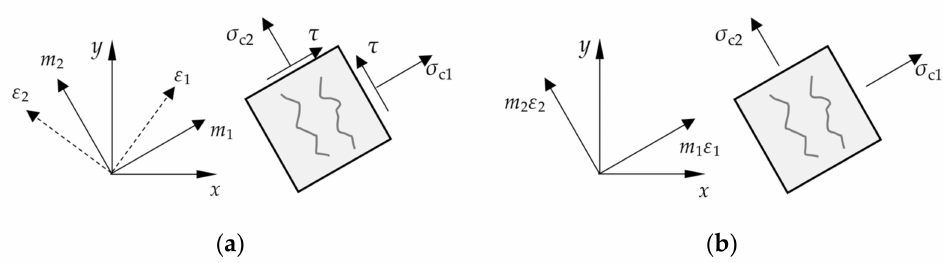
Figure 11. Crack models. ( a ) Fixed; ( b ) rotated.